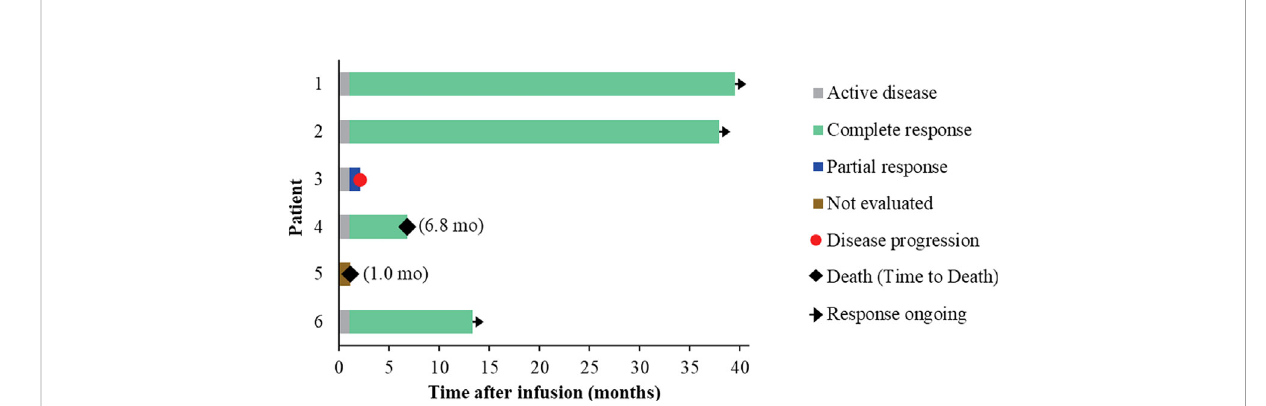
FIGURE 2 Treatment response of each patient after NAHTC infusion and the duration of